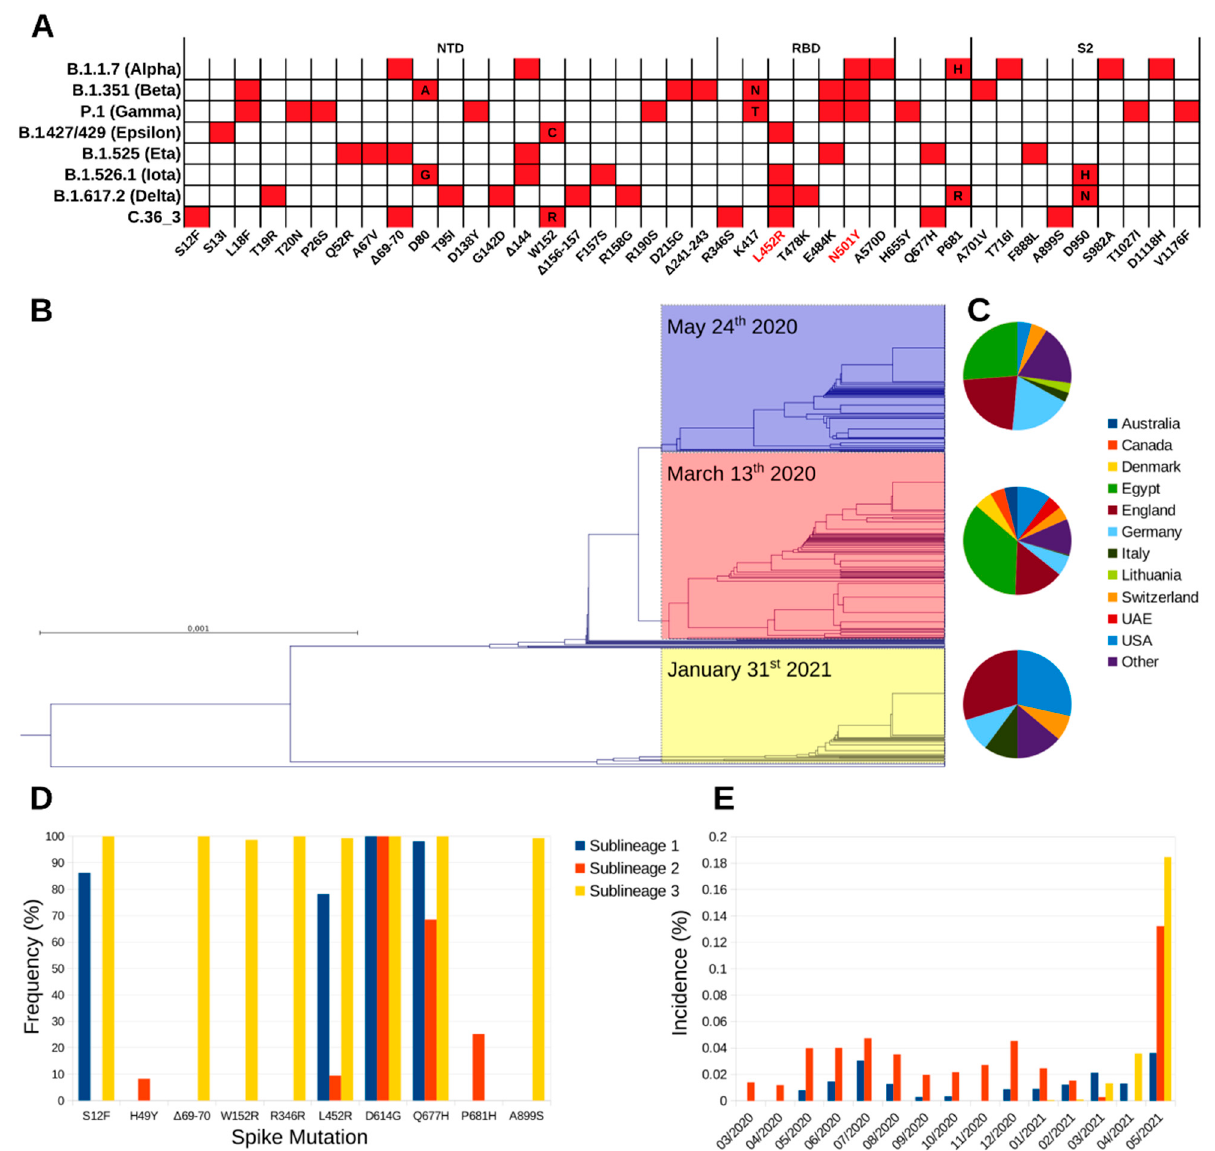
Figure 1. Phylogeny and distribution of lineage C.36. ( A ) Spike amino acid mutations associated with the currently most relevant VOC and VOI. Mutations associated with increased affinity are highlighted in red. ( B ) Phylogram of C.36 spike amino acid sequences deposited on GISAID before 18 May 2021, with sublineage 1, 2, and 3 highlighted in blue, red, and yellow, respectively. For each sublineage, the first sampling date is reported. ( C ) Geographic distribution of the three sublineages. ( D ) Spike amino acid mutations most frequently associated to each C.36 sublineage. ( E ) Sublineages global monthly incidence normalized by the total number of sequenced isolates over the same period.